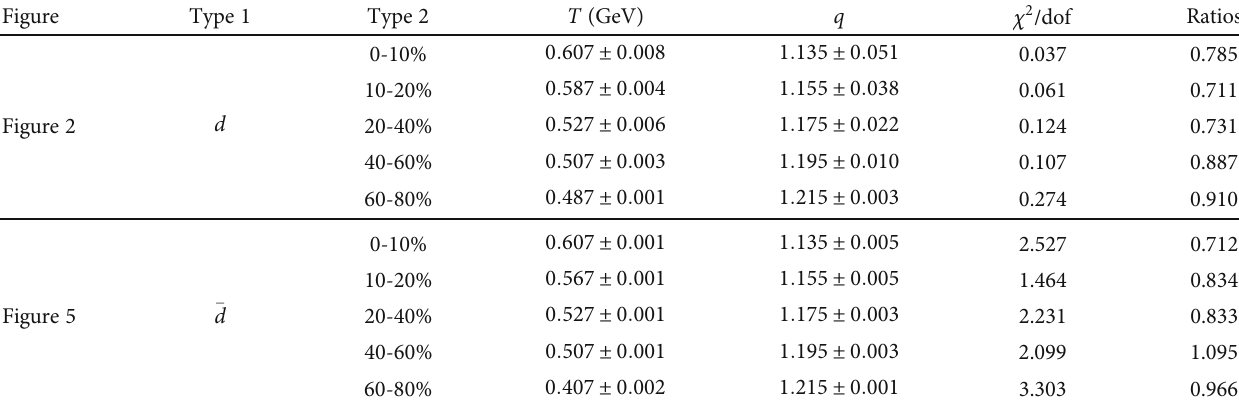
Figure 3: Deuteron transverse momentum spectra in Au+Au collisions at centralities. Calculations are shown by the solid lines. Experimental data taken from the STAR Collaboration [20] are represented by the symbols. Table 3: Values of T , q , and χ 2 /dof corresponding to the curves in Au+Au collisions at 60%, and 60-80% centralities. The “ Ratios ” is the average ratios of experimental data to